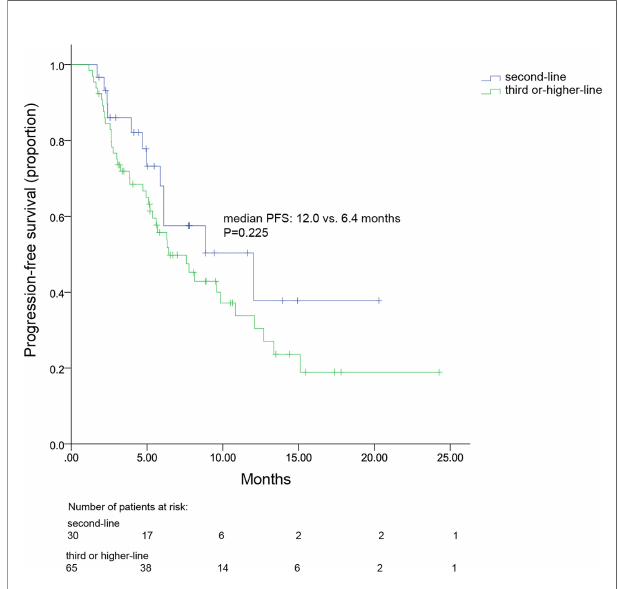
FIGURE 2 | Kaplan – Meier curve for progression-free survival of patients receiving pyrotinib plus vinorelbine as their second-line or third-or-higher-line